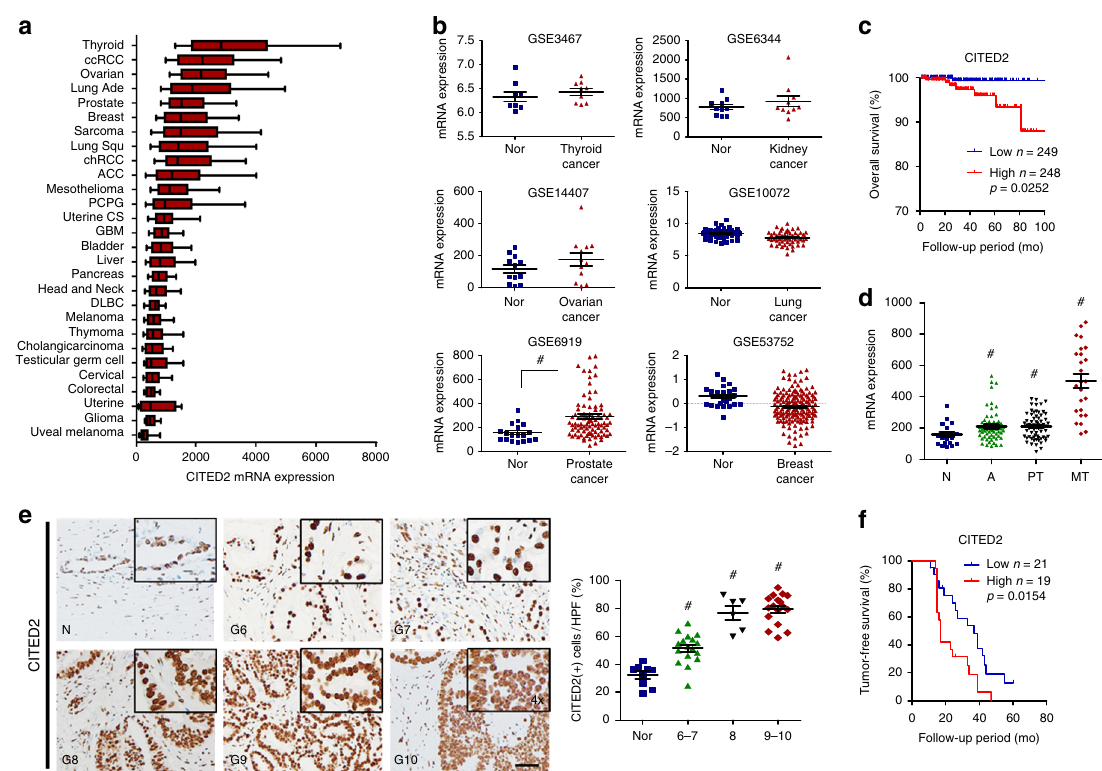
Fig. 1 CITED2 overexpression is associated with poor prognosis in prostate cancer. a CITED2 mRNA expression in 28 different types of cancer as determined by RNA-Seq V2 RSEM. Box plots indicate the distribution of values and the middle thick line in the box shows mean value and whiskers represent 10 – 90th percentile. Results were obtained from The Cancer Genome Atlas (TCGA) cancer provisional data sets based on TCGA Research Network (http://cancergenome.nih.gov). The abbreviations and the number of patients are described in the Methods section. b CITED2 mRNA levels in normal (blue squares) and cancer tissues (red triangles) of thyroid, kidney, ovarian, lung, prostate, and breast (GSE data sets). c Kaplan – Meier overall survival analysis of prostate cancer patients on TCGA. P value was calculated by log-rank test. d CITED2 mRNA levels in human prostate cancer tissues of data set GES6919. N normal prostate tissue (blue squares), A normal prostate tissue adjacent tumor tissue (green triangles), PT prostate primary tumor tissue (black inverted triangles), MT metastatic prostate tumor tissue (red diamond). e Representative images of human prostate adenocarcinoma tissues immunostained with anti-CITED2 antibody. Abbreviations at the left bottoms of images: N normal prostate tissue (blue squares), G6 – 10 (6 – 7, green triangles; 8, black inverted triangles; 9 – 10, red diamond) Gleason scores 6 – 10 of prostate cancer (left panel). The immunostaining scores were calculated by counting stained cells and presented as dot plots (right panel). The scale bar represents 50 μ m. f Kaplan – Meier tumor-free survival analysis of prostate cancer patients. P value was calculated by log-rank test. The horizontal lines in all dot plots represent the means ± SE and # P < 0.05 versus the